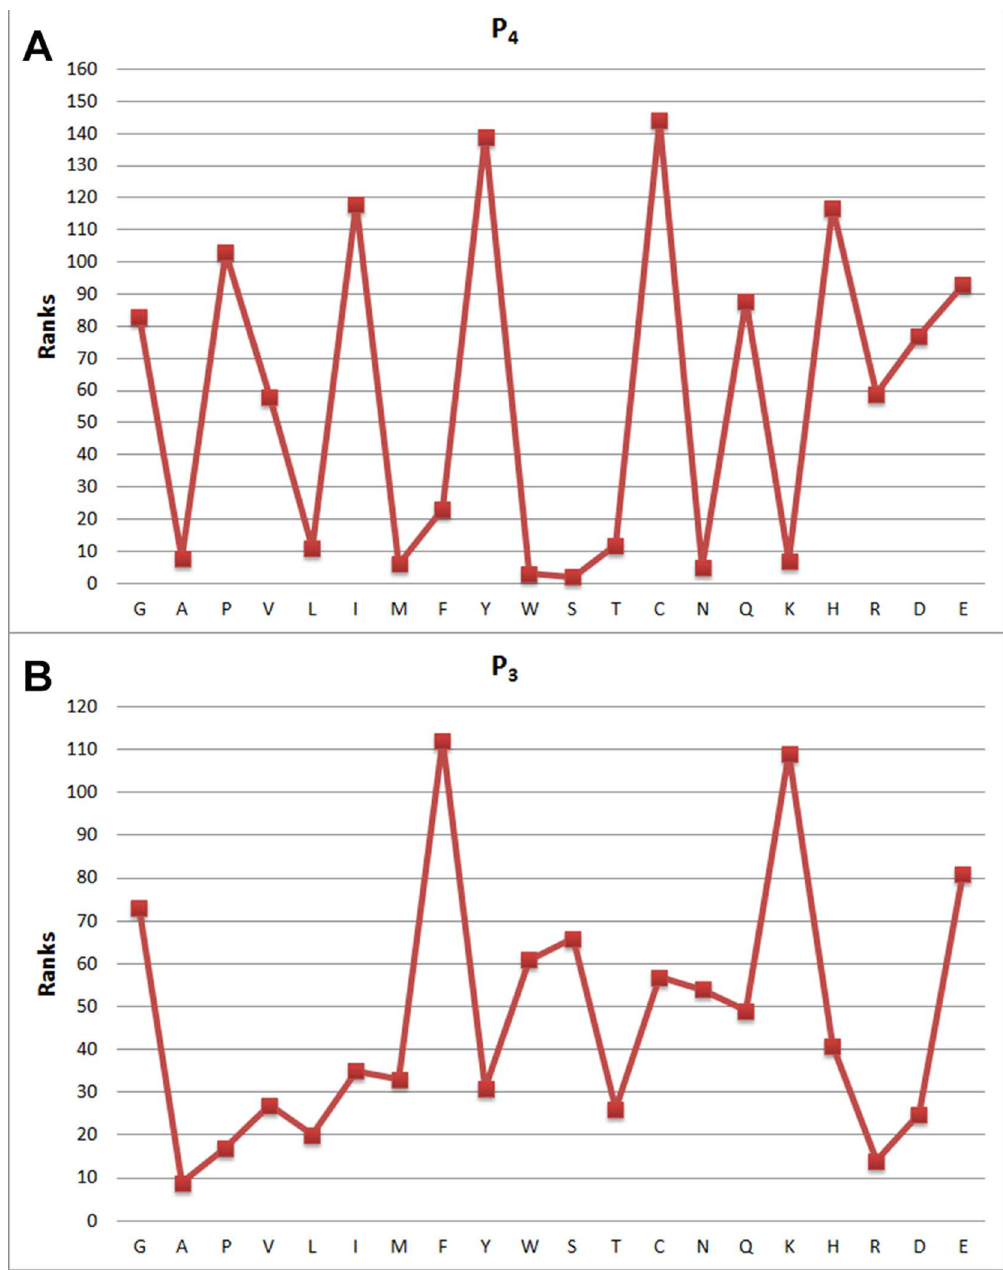
Figure 4. Feature weights of (a) P 4 and (b) and P 3 .